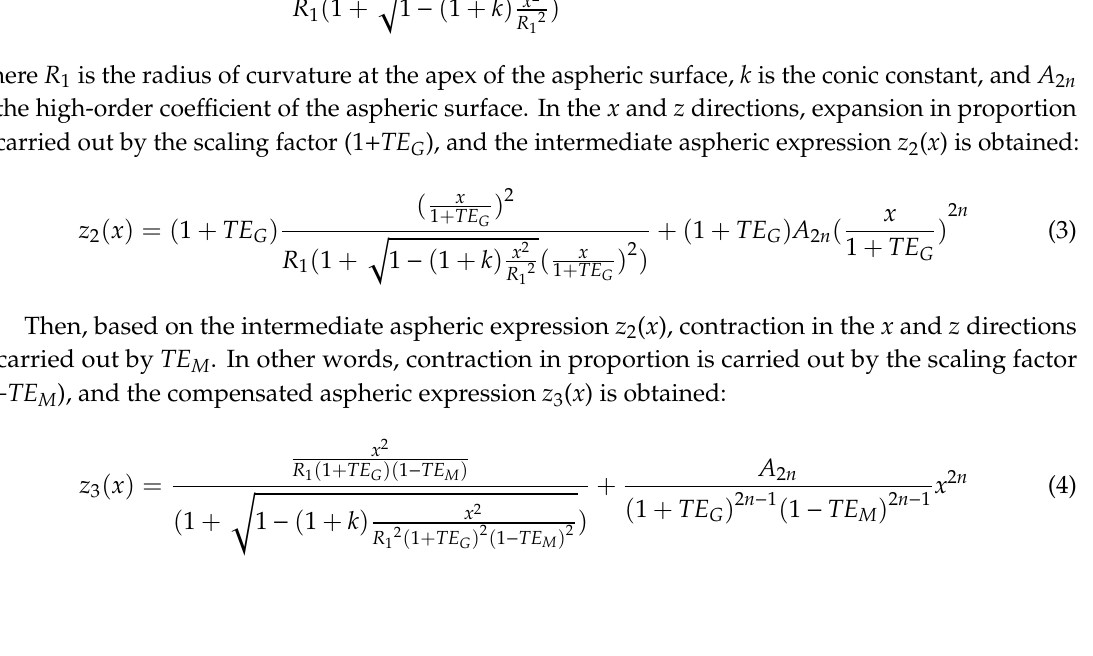
Figure 5. Logic diagram of the mold pre-compensation method based on mathematical analysis .